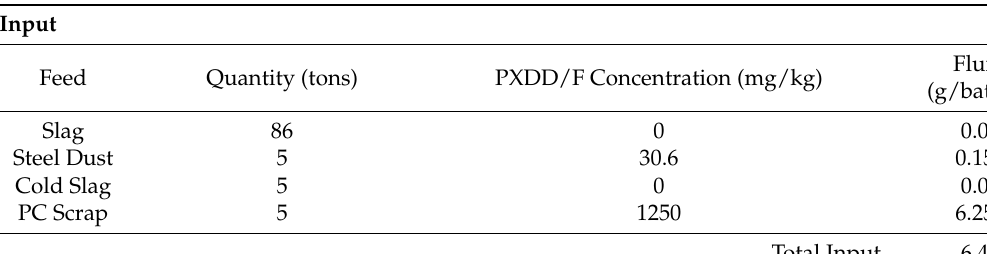
Table 12. Dioxin and furan mass balance for the zinc fuming plant [96].